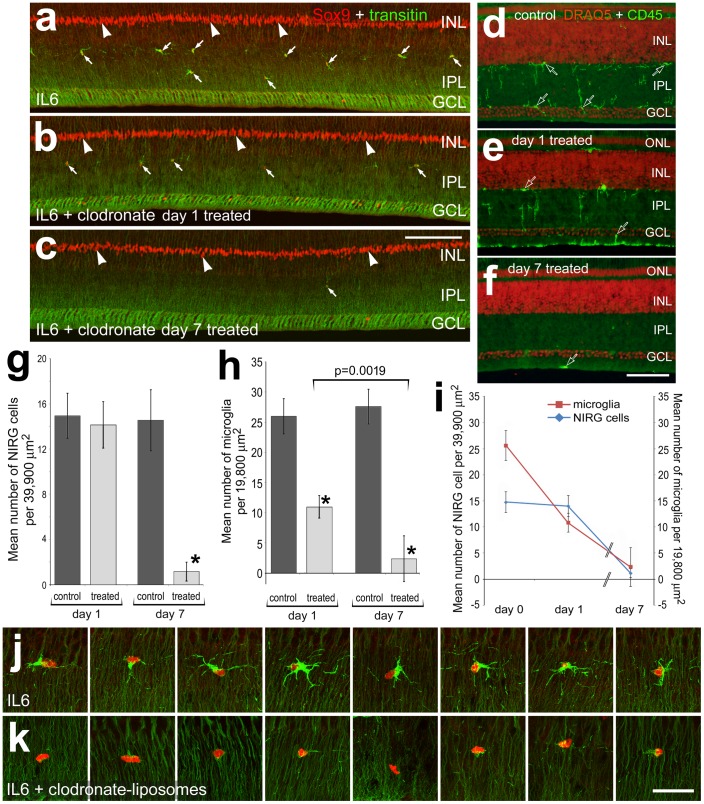
A partial depletion of the microglia influences the phenotype and survival of the NIRG cells.The dose of clodronate-liposomes was titered-down so that nearly one-half of the microglia survived at 1 day after treatment. Retinas were obtained 1 or 7 days after treatment with IL6 alone (control) or IL6 with clodronate-liposomes (treated). Vertical sections of the retina were for Sox9 (red) and transitin (green; a–c, j and k), or DRAQ5 (red) and CD45 (green; d–f). The histogram in g illustrates the mean (±SD) illustrates the mean (±SD) number of NIRG cells in the IPL and INL at 1 and 7 days after treatment. The histogram in h illustrates the mean (±SD) number of microglia in the retina at 1 and 7 days after treatment. The plot in i combines the data from the histograms in g and h to demonstrate the depletion of microglia and NIRG cells over time following treatment with IL6/clodronate-liposomes. Panels j and k include representative high-magnification images of representative NIRG cells within the IPL of control (IL6 alone) or treated (IL6+ clodronate-liposomes) retinas at 1 day after treatment. Images were obtained using confocal (a–c, j and k) and widefield (d–f) microscopy. Images of control and treated retinas were obtained using identical microscope, camera settings, and post-acquisition processing settings. Arrows indicate NIRG cells, hollow arrows indicate the somata of microglia, and arrow-heads indicate the nuclei of Müller glia. The scale bar (50 µm) in panel c applies to a–c, and the bar (10 µm) in k applies to j and k. Significance of difference was determined by using a one-way ANOVA (p<0.0001). Significance of difference between control and treated groups (*p<0.0001), and between treatment time-points (bracket and p-values) was determined by using a post-hoc two-tailed Student’s t-test. Abbreviations: ONL – outer nuclear layer, INL – inner nuclear layer, IPL – inner plexiform layer, GCL – ganglion cell layer.